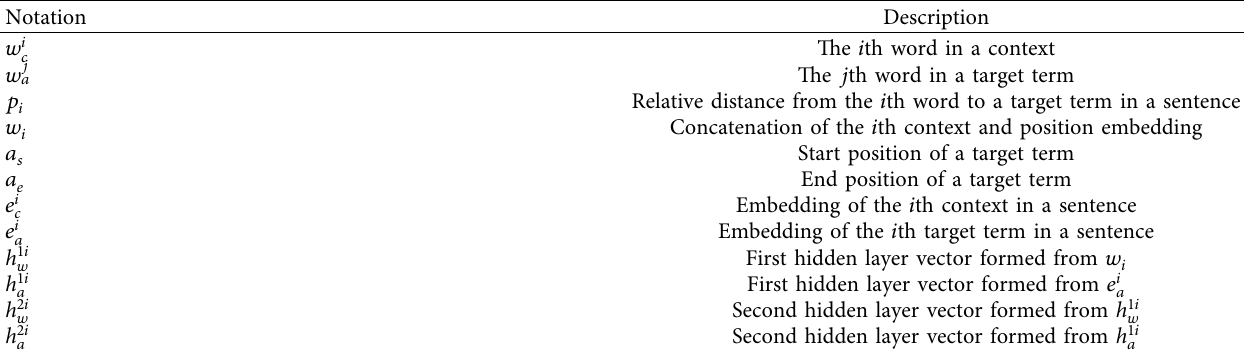
Figure 1: Architecture of MI-biGRU. Table 1: Component description of the proposed